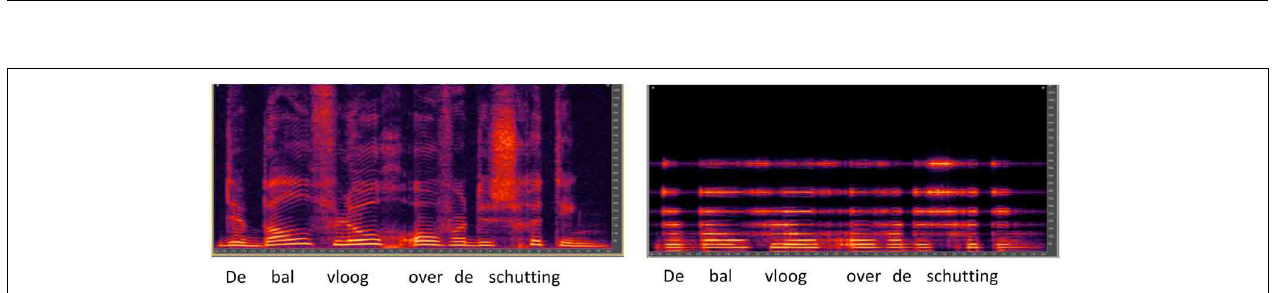
FIGURE 2 | Spectrograms for Dutch sentence “De bal vloog over de schutting” (“The ball flew over the fence” in English), shown for unprocessed speech (left panel) or with the CI simulation (right panel).